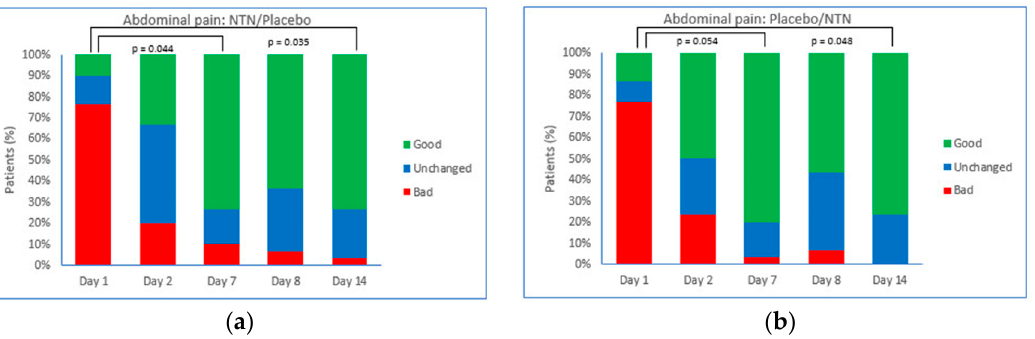
Figure 4. Evolution of abdominal pain. Proportion of patients with good, unchanged, or bad Likert scores in groups randomized to receive: ( a ) NTN on Days 1–7 with crossover to placebo on Days 8–14; p = 0.044, significant increase in good abdominal pain feeling at Day 7. At study end, significantly more patients reported good symptoms ( p = 0.035); ( b ) placebo on Days 1–7 with crossover to NTN on Days 8–14; p = 0.054, no significant increase in good abdominal pain feeling at Day 7. At study end, significantly more patients reported good symptoms ( p = 0.048). Good: somewhat good/good/very good; Unchanged: same; Bad: somewhat bad/bad/very bad; NTN: novel therapeutic of natural